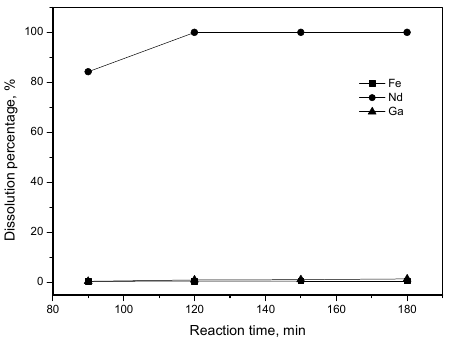
Figure 5. Effect of time on the leaching of the oxide mixtures by 1.0 M HCl in EG. Operation conditions: pulp density = 50 g/L, T = 25 °C, stirring speed = 400 rpm.